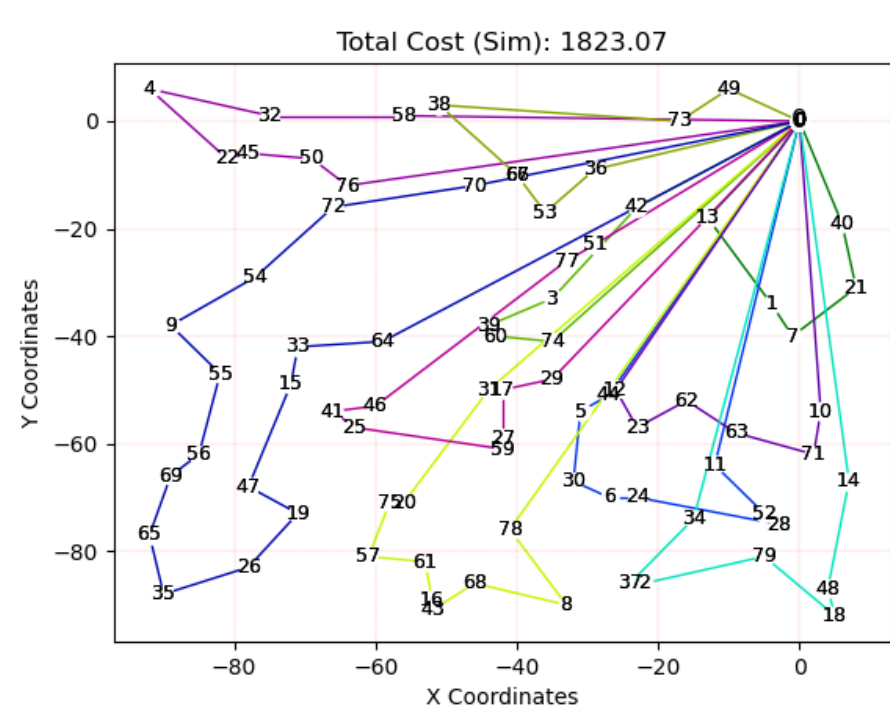
Figure 11. Best solution for VRP-Stochastic